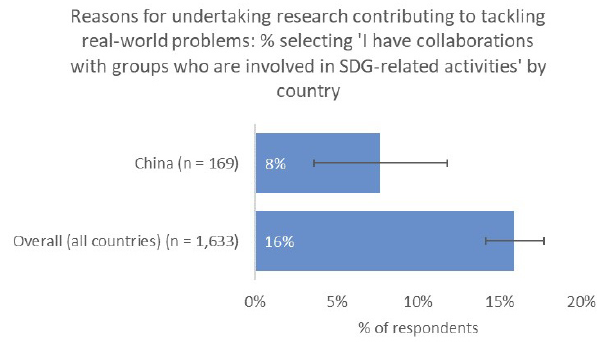
Figure 11. Relative proportion of researchers with collaborators who are involved in SDG-related